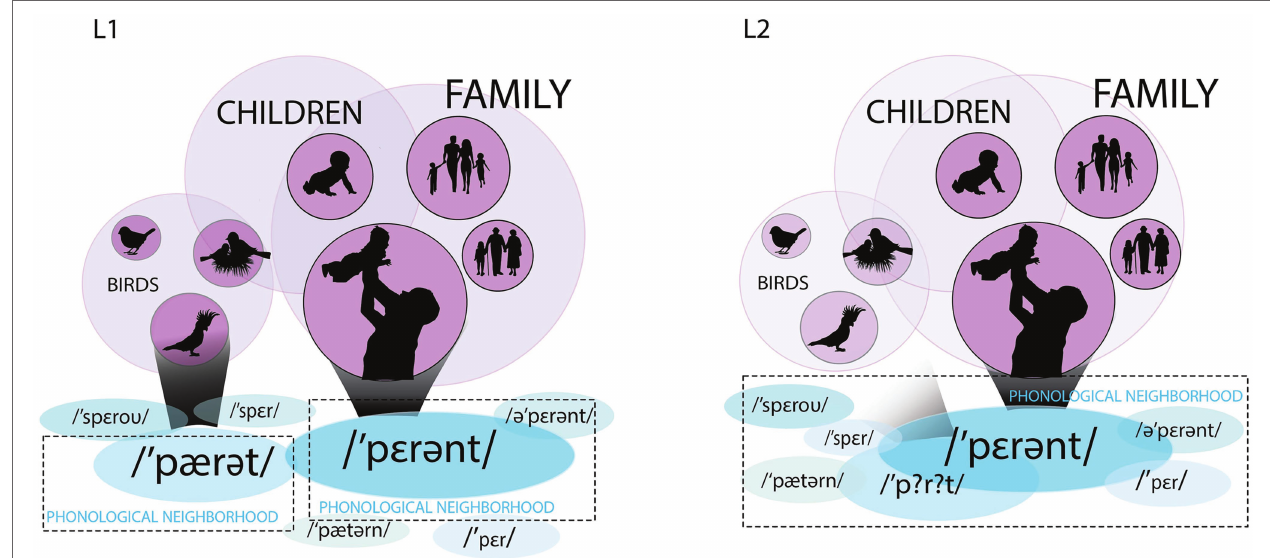
FIGURE 1 | L1 and L2 lexical representations. Panel on the left represents the word parrot and a similar-sounding word parent in L1 (in British English), and panel on the right – the same words in L2. The blue ellipses at the bottom represent the phonological neighbors and similar-sounding words. The size of the ellipses represents the lexical frequency of the words. The mauve circles represent the semantic representations and their semantic fields, while the grey cones represent the activation spreading from the form to meaning. In L1, the words parrot and parent are differentiated at the phonological level and belong to different neighborhoods. Each word activates its corresponding meaning. In L2, both the form and meaning of the word parrot are fuzzy. It is phonologically encoded as /p?r?t/ and is likely to be confused with /p ɛ r ə nt/, a high-frequency and more familiar word. Semantically, /p?r?t/ can activate “parent” and “family,” but also “birds,” rather than “parrot” because the exact semantic referent is unavailable given the fuzzy semantic